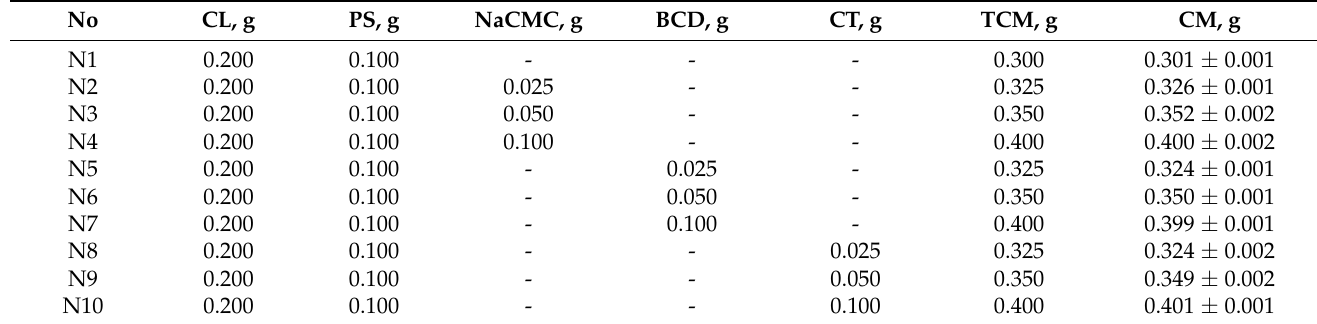
Table 1. Compositions of the cranberry lyophilizate-containing capsules.